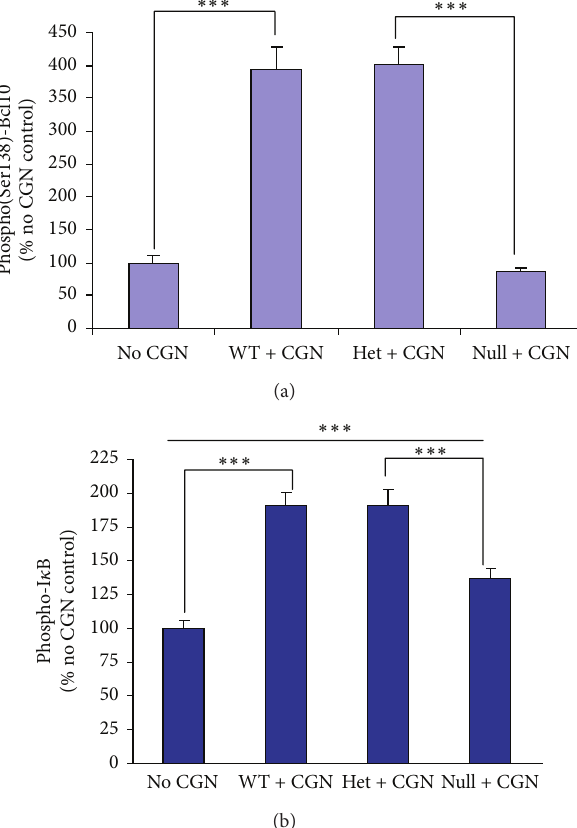
Figure 4: Carrageenan-induced increase in RelA is reduced and is absent in RelB in Bcl10 null mice. (a) Nuclear RelA, measured by oligonucleotide assay, increased by ∼ 89% in the wild type and heterozygous mice following carrageenan but only by about 40% in the Bcl10 null mice ( 𝑃 < 0.001 ). (b) In contrast, the increase in RelB was completely inhibited in the Bcl10 null mice but increased by ∼ 75% in the heterozygous and wild type mice following carrageenan ( 𝑃 < 0.001 ). CGN: carrageenan; WT: wild-type; Het: heterozygous; N.D.: no difference.